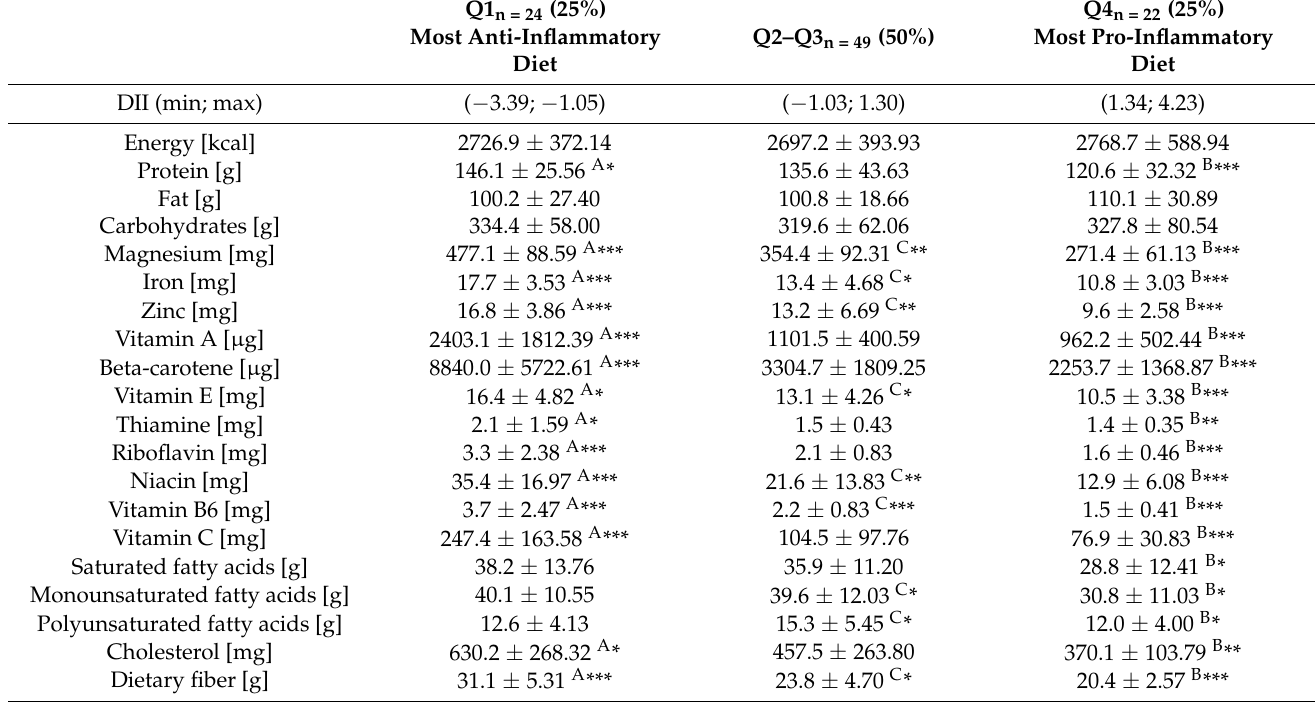
Table 2. Daily energy, macronutrient, and micronutrient intake in participants (mean ± SD). Q1 n = 24 (25%) Most Anti-Inflammatory Q2–Q3 n = 49 (50%) Diet